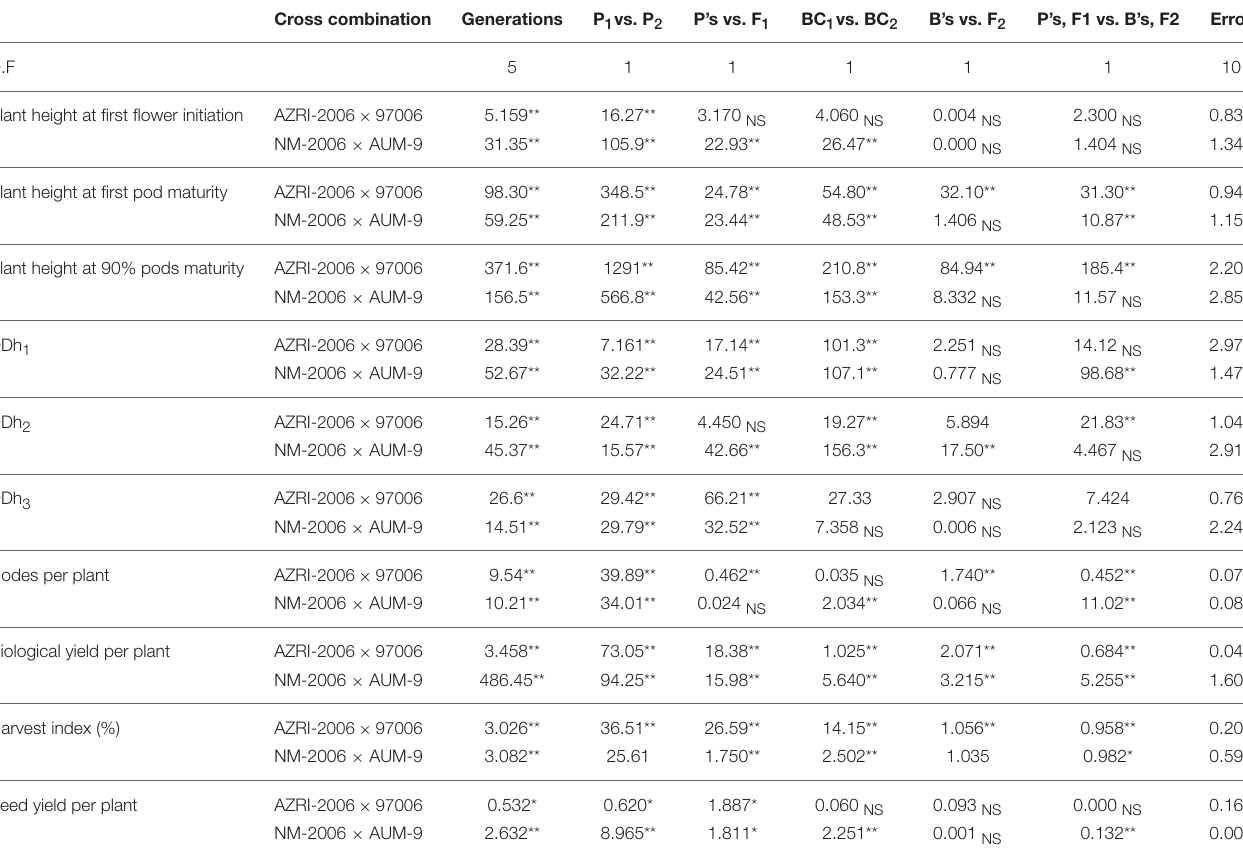
TABLE 3 | Mean squares with partitioned generation variances for various traits in two crosses of